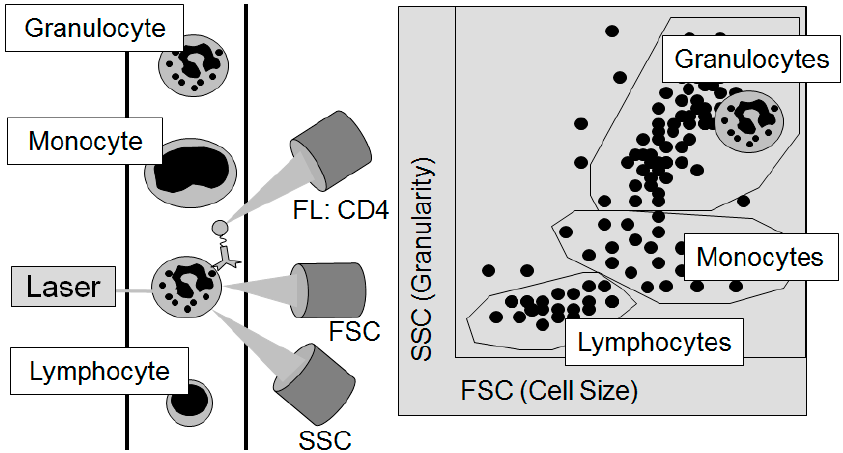
Figure 3. The principle of flow cytometry to differentiate the individual cellular components of the blood: The Forward Scatter (FSC) measures the acute-angular diffraction of the light and depends on the cell’s volume. The Sideward Scatter (SSC) measures the rectangular diffraction of the light and depends on the granularity of the cell, the size and structure of its core, and the amount of vesicles contained in it. With the help of FSC and SSC, the individual cells contained in the blood can be differentiated. For further sub-differentiation, e.g., by the sub-type of cell or its functional status, marker molecules on the surface of the cells, the so-called cluster of differentiation (CD), are used. In this figure, a granulocyte passes the laser light (left part of the figure). After sorting by cell size and granularity according to the light detected by the FSC and the SSC as displayed in the right part of the figure, the granulocyte could then be further analyzed for the frequency of CD4 on its surface by the signal of fluorescent (FL) antibodies against CD4.